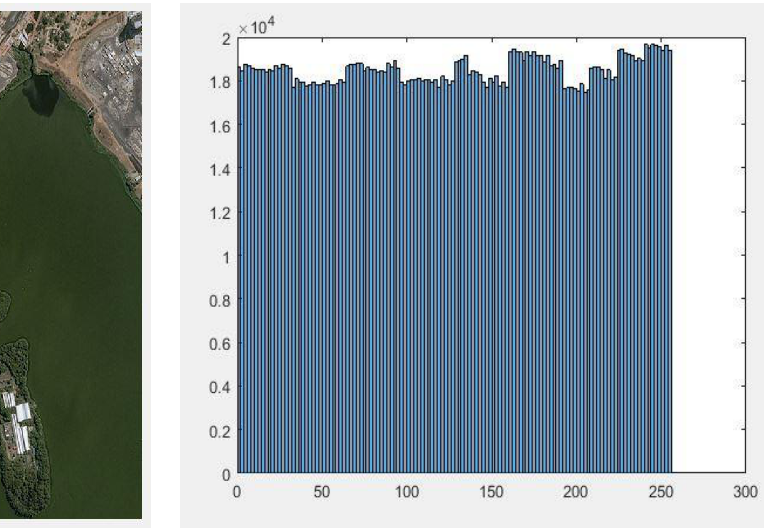
Figure 10. Histogram Encrypted